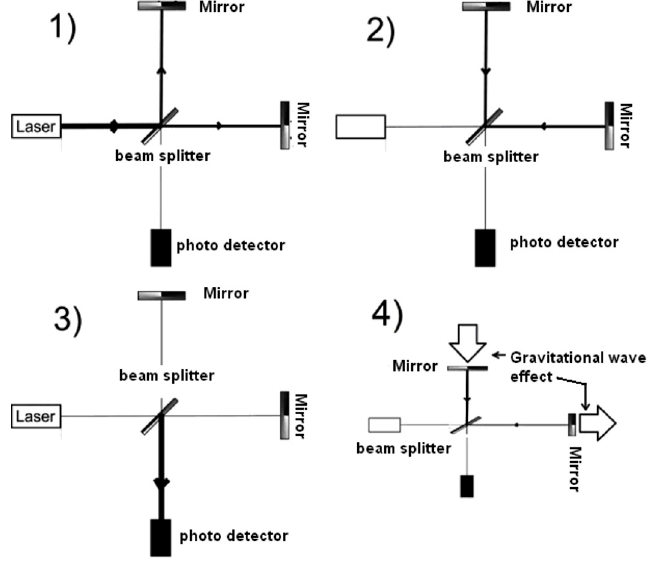
Figure 8. Schematic of an interferometer for detecting gravitational waves.